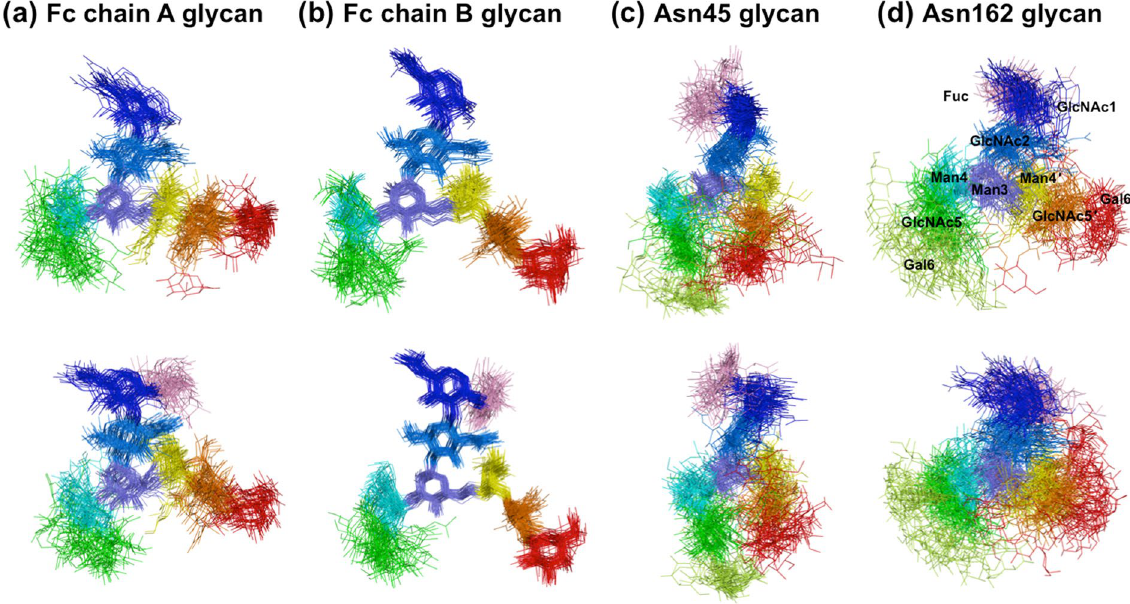
Figure 2. Superimposition of N -glycan conformers obtained from REMD simulation of IgG1-Fc/sFc γ RIIIa complexes. One hundred conformers of the superimposed N -glycans of nonfucosylated and fucosylated systems are shown in the upper and lower panels, respectively: ( a ) Fc chain A glycan; ( b ) Fc chain B glycan; ( c ) Asn45 glycan; ( d ) Asn162 glycan. Each sugar residue is colored as follows: Fuc (pink); GlcNAc1 (blue); GlcNAc2 (marine blue); Man3 (slate); Man4 (cyan); Man4 ′ (yellow); GlcNAc5 (green); GlcNAc5 ′ (orange); Gal6 (lemon); Gal6 ′ (red).